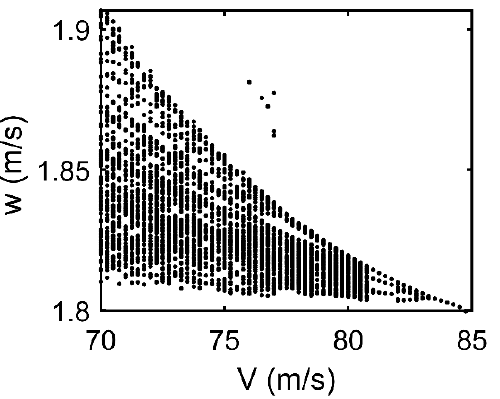
Figure 8. Bifurcation diagram of the delay-free model respecting to forward speed V.